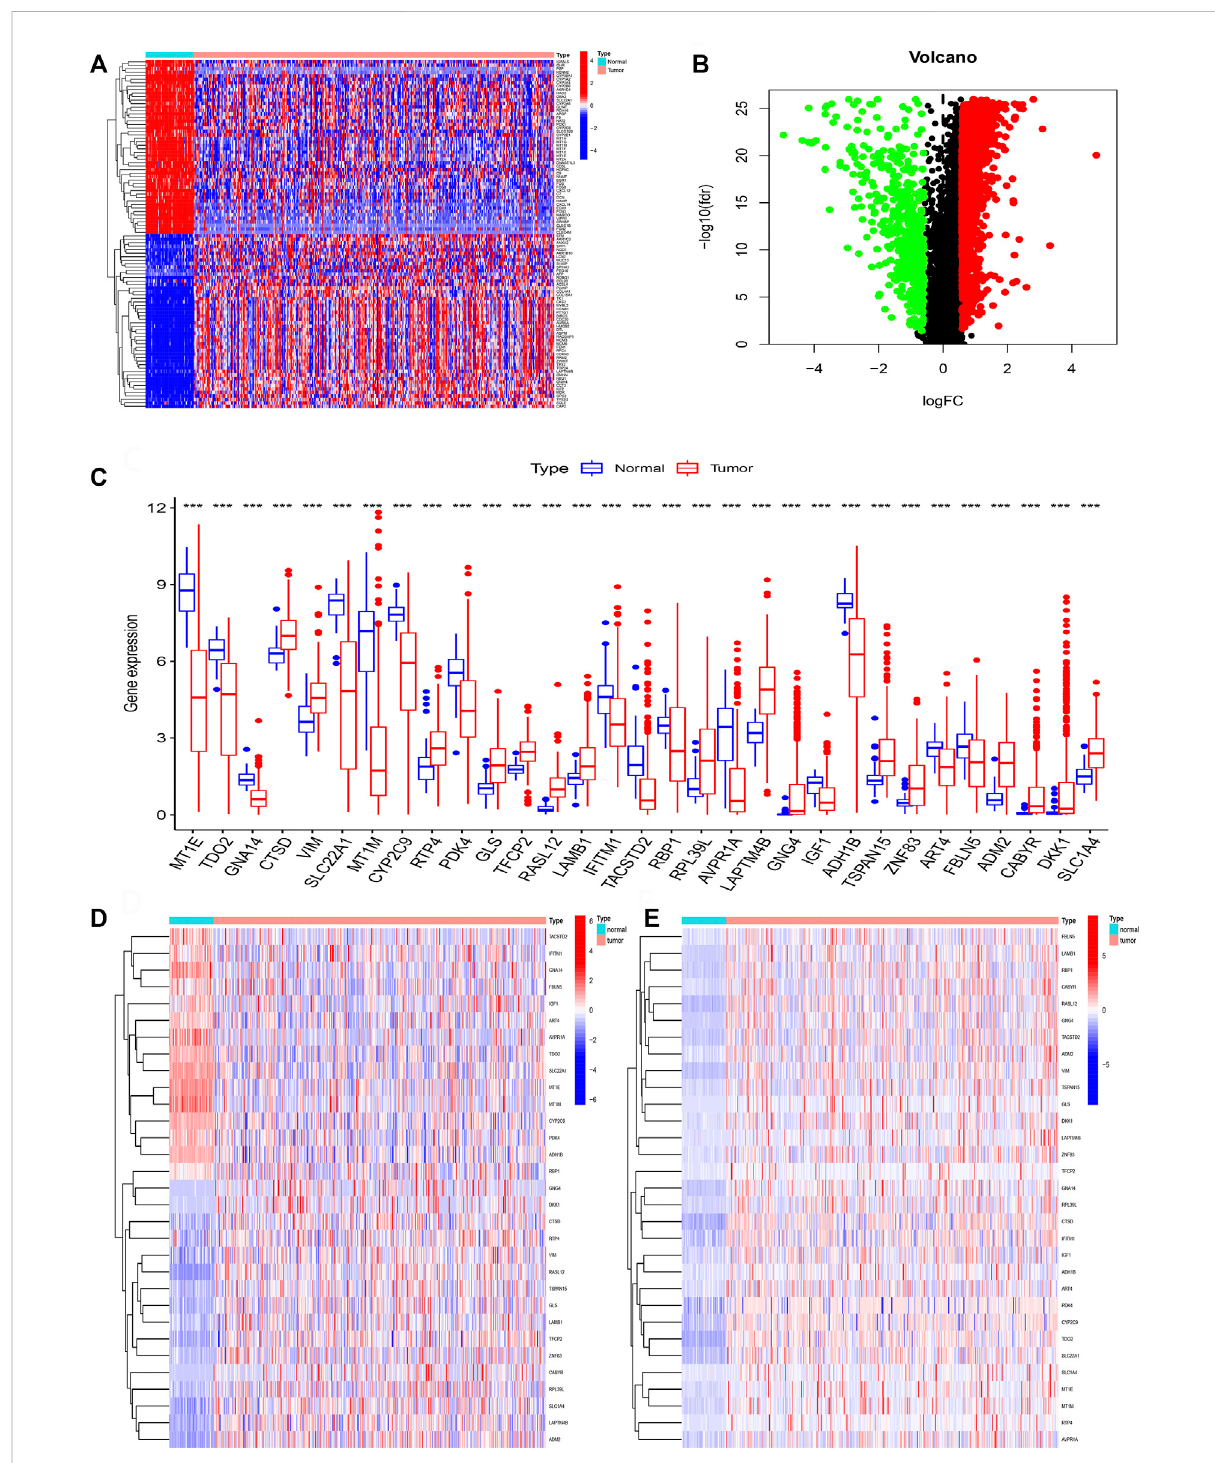
FIGURE 2 Identi fi cationofDNAmethylation-drivengenes. (A) TheheatmapofDEGs. (B) ThevolcanomapofDEGs. (C) Expressionof31DNAmethylation- drivengenes. (D) Theheatmapofmethylationlevelsabout31DNAmethylation-drivengenes. (E) Theheatmapofexpressionof31DNAmethylation- driven